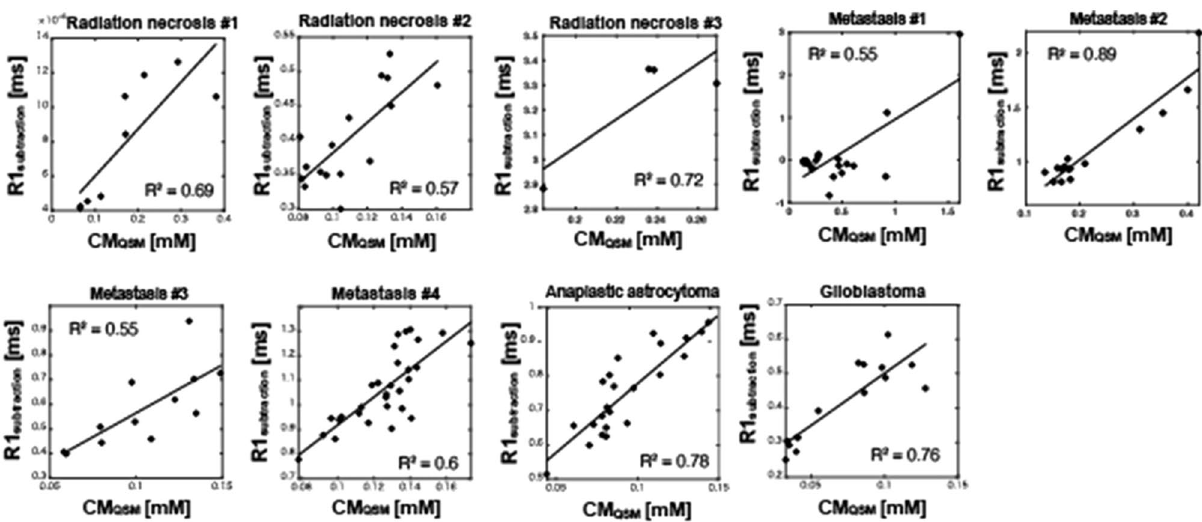
Figure 4. Relationship between R1 subtraction and CA qsm for each brain disease. Mean R1 subtraction values were plotted against mean CA qsm values on tumor lesions. The tumor lesions were defined by drawing region-of- interest (ROI) on the R1 map after contrast agent